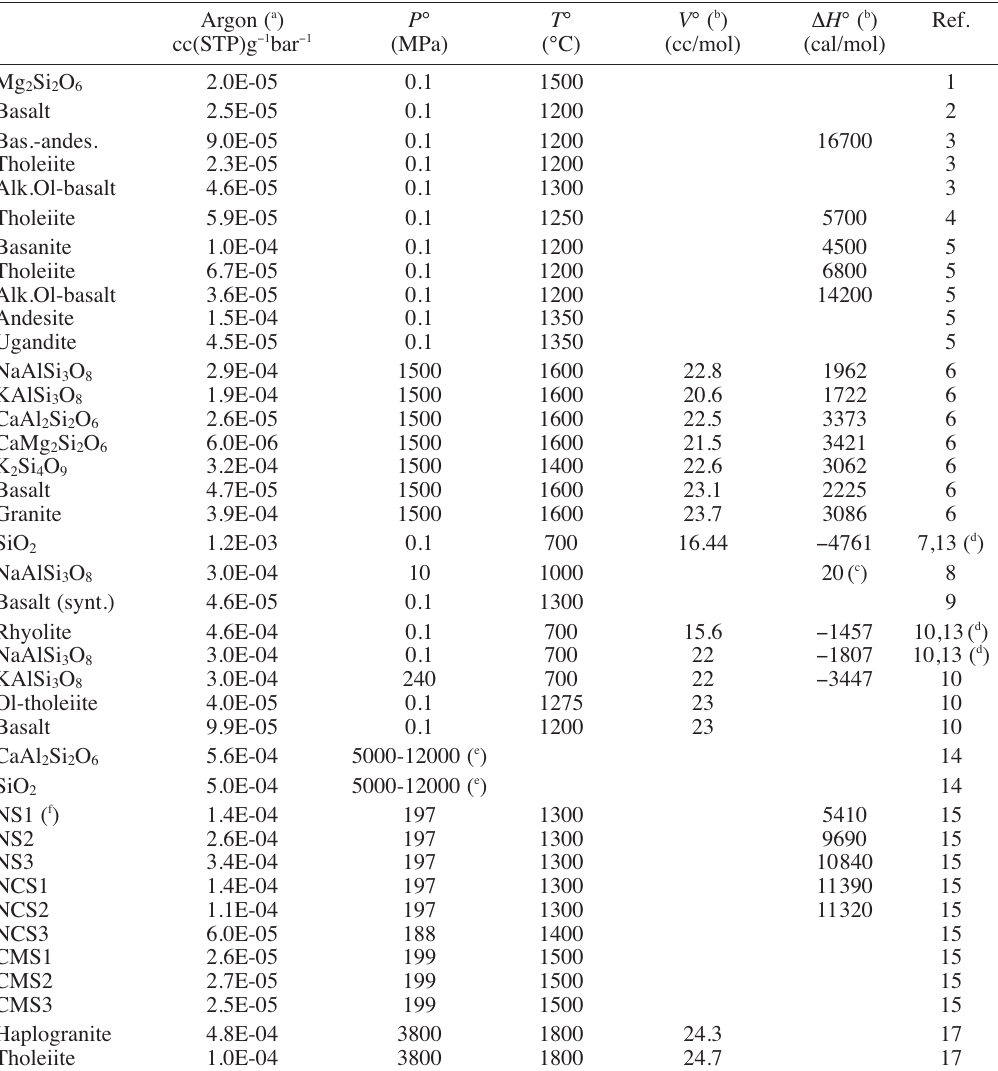
Table I. Noble gas solubility in melt and glasses, and parameters for pressure and temperature